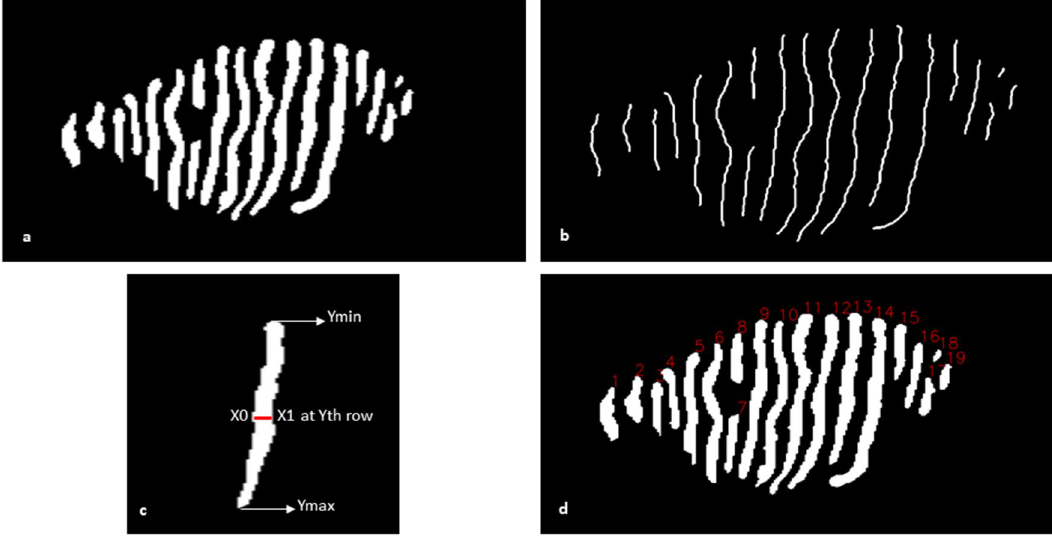
Figure 2. Morphometric parameters assessment of MG. ( a ) Binary segmented image, ( b ) skeletonized MGs of one-pixel width, ( c ) Individual gland width measurement. The Red line indicates the leftmost white pixel (X 0 ) and rightmost white pixel (X 1 ) at the Y th row, and ( d ) Number of each MG is presented on top of each